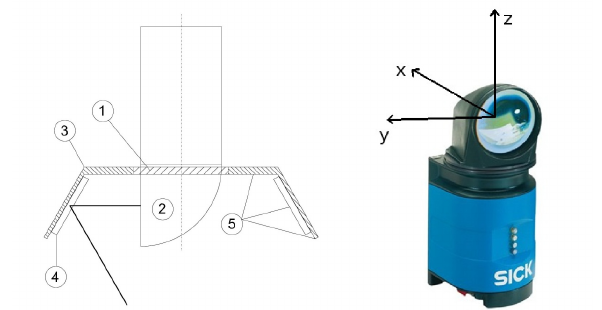
Figure 6. a) Scheme of modification (left) b) scanner coordinate system (right)